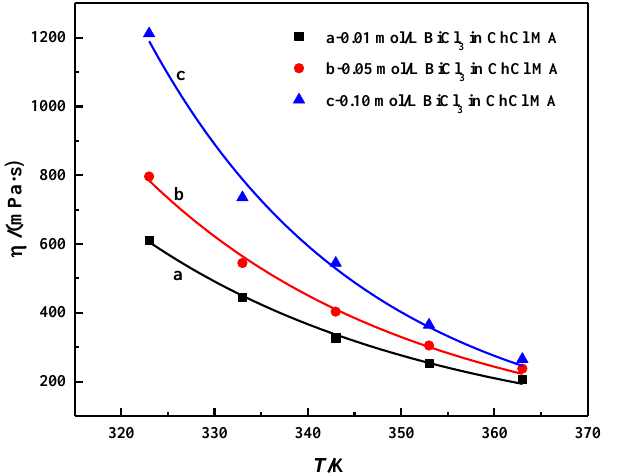
Figure 4. The relationship between the viscosity of the ChCl-MA-BiCl 3 system and the change of BiCl 3 concentration with temperature.